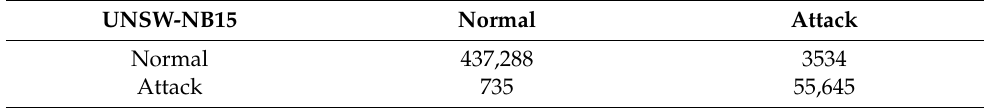
Table A1. Layer 1 confusion matrix for UNSW-NB15 Dataset.